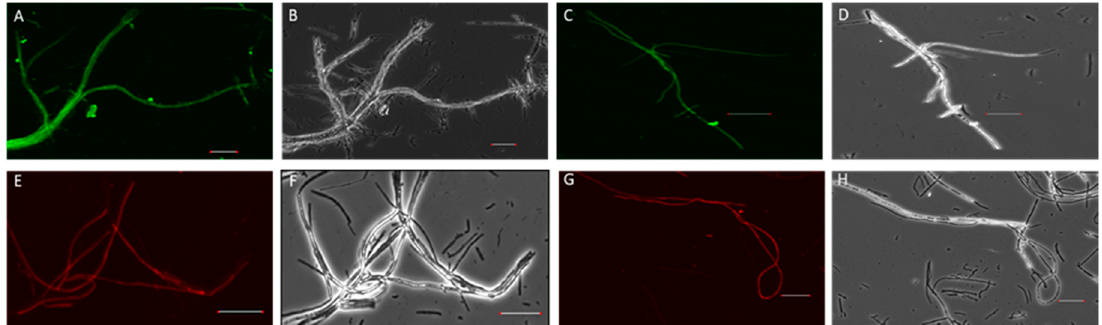
Figure 1. Confocal microscopy images of transgenic reporter mycelia (NEA12 and E1) expressing sgfp and DsRed genes. ( A ) NEA12 mycelia expressing SGFP. ( C ) E1 mycelia expressing SGFP. ( E ) NEA12 mycelia expressing DsRed. ( G ) E1 mycelia expressing DsRed. ( B ), ( D ), ( F ), and ( H ) are bright field images of ( A ), ( C ), ( E ), and ( G ), respectively. Scale bar = 40 µm. Table 2. Infection frequencies obtained for different reporter gene-containing endophyte strains.